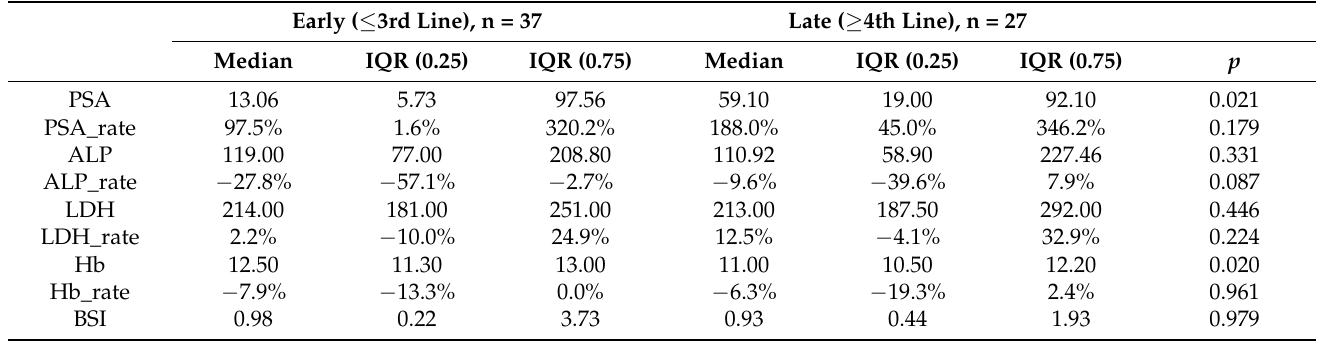
Table 3. Comparison between 2 groups (BSI_low vs. BSI_high) (MWU test). BSI_Low (<0.61), n = 21